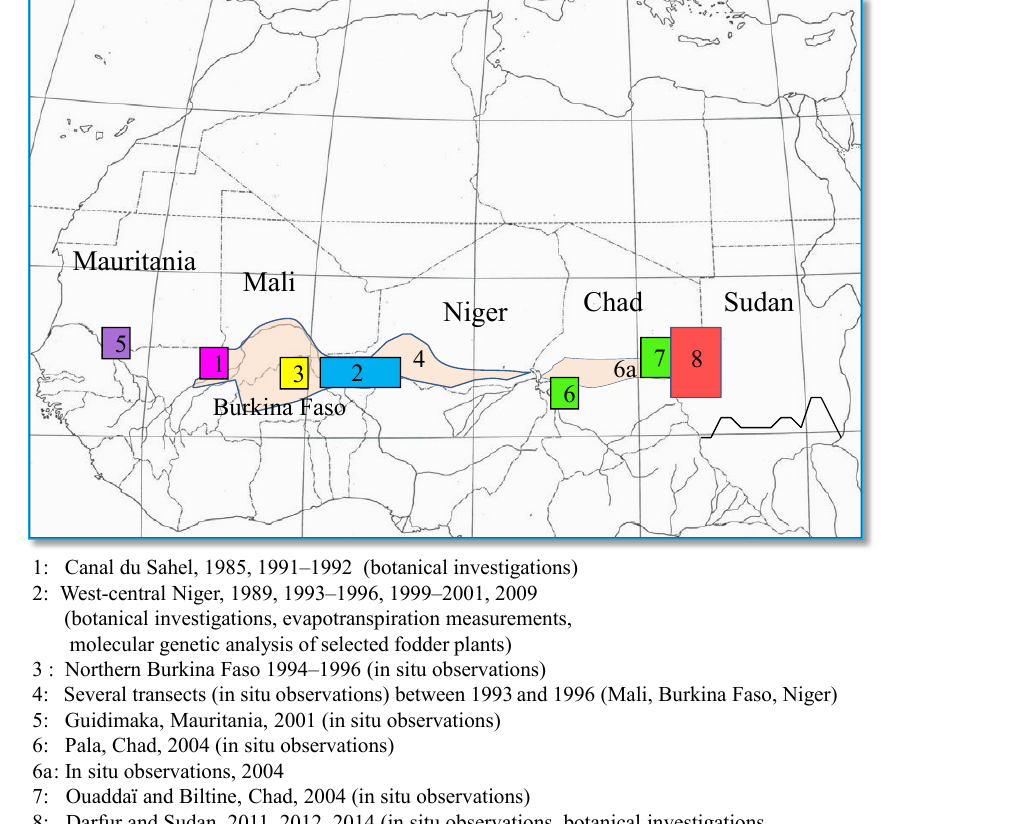
Figure 1. Position of research projects and transects of